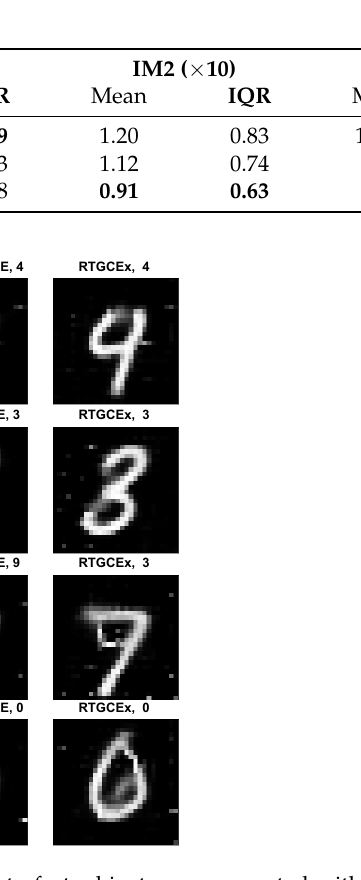
Figure 9. Examples of original and counterfactual instances generated with CFPROTO, RTGCEx without AE, and